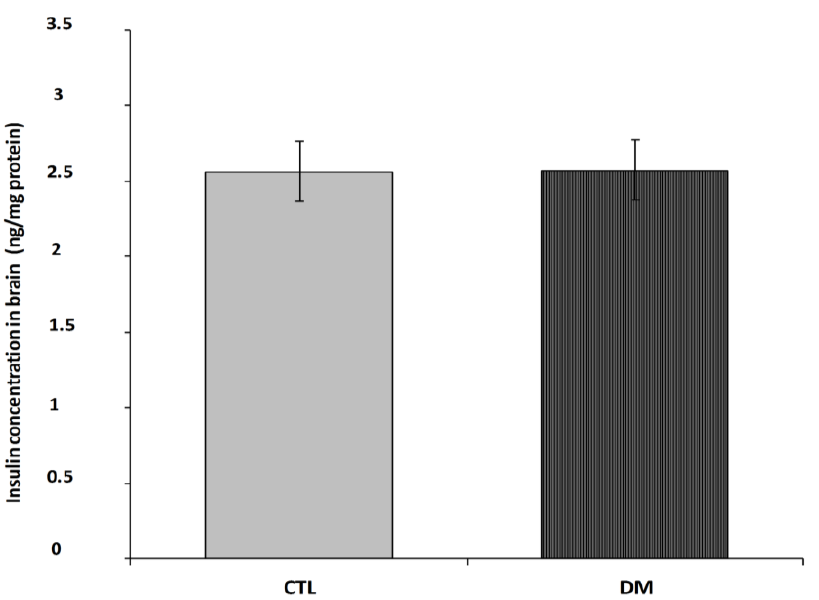
Figure 5. Insulin level in prefrontal cortex of diabetic mice. Data are expressed as mean ± SEM ( n = 6). CTL: Control mice, DM: Diabetic mice.